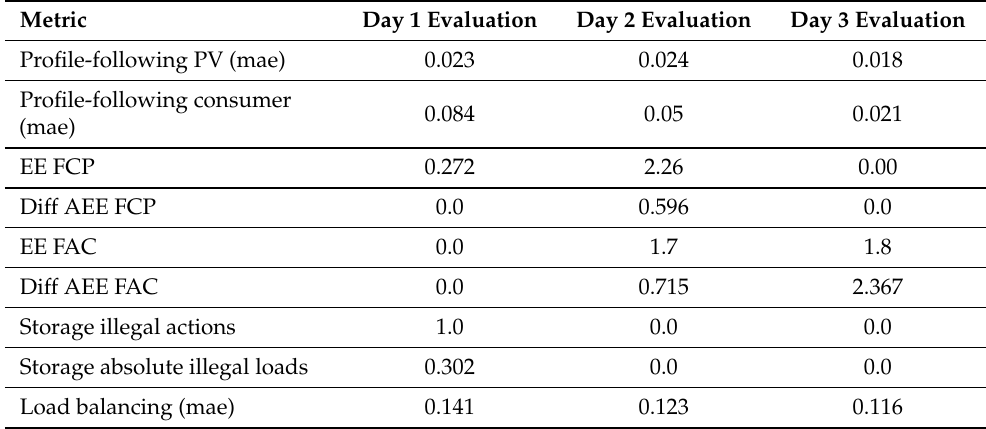
Table 8. Generalised training quantitative evaluation for each problem instance.